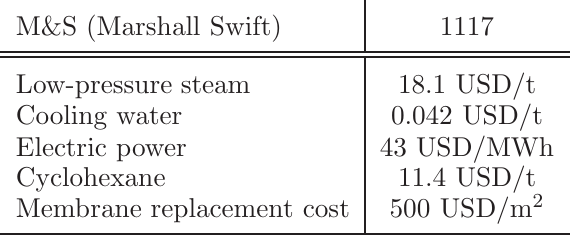
Table 9 Technological streams of adiabatic pervaporation, D+PV+D.